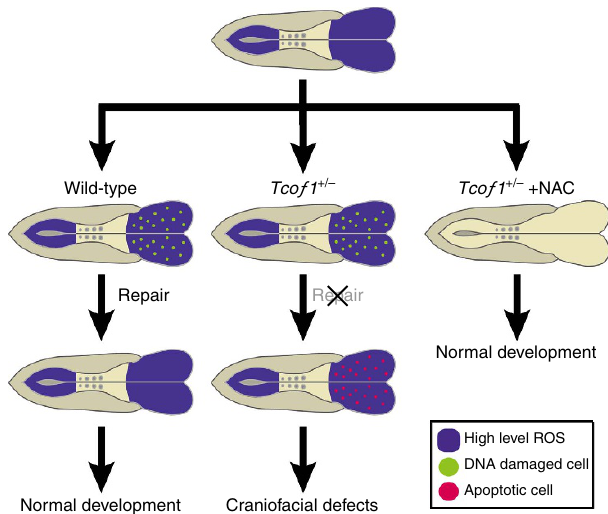
Figure 8 | Summary of Tco f 1 /Treacle function in neuroepithelial survival and prevention of neuroepithelial apoptosis by NAC treatment. Our results uncovered that endogenous ROS accumulate in the anterior and posterior neuroepithelium of E8.5 embryos. Thus DNA damage response/ repair machinery is required for prevention of oxidative DNA damage. In Tco f 1 mutant embryos, neuroepithelial cells undergo apoptosis due to the impairment of DNA damage repair function. In contrast, scavenge of ROS by antioxidant treatment represses apoptotic elimination of neuroepithelial cells, and rescue the craniofacial abnormalities in Tco f 1